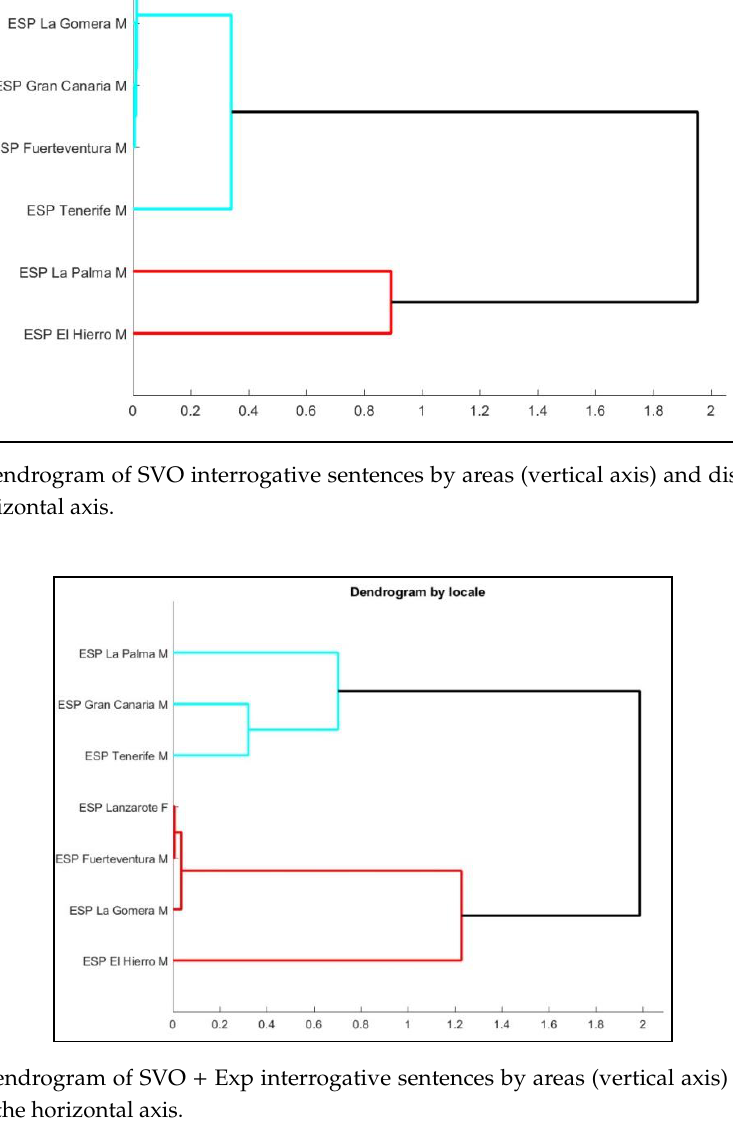
Figure 11. Dendrogram of SVO interrogative sentences by areas (vertical axis) and distance values along the horizontal axis.